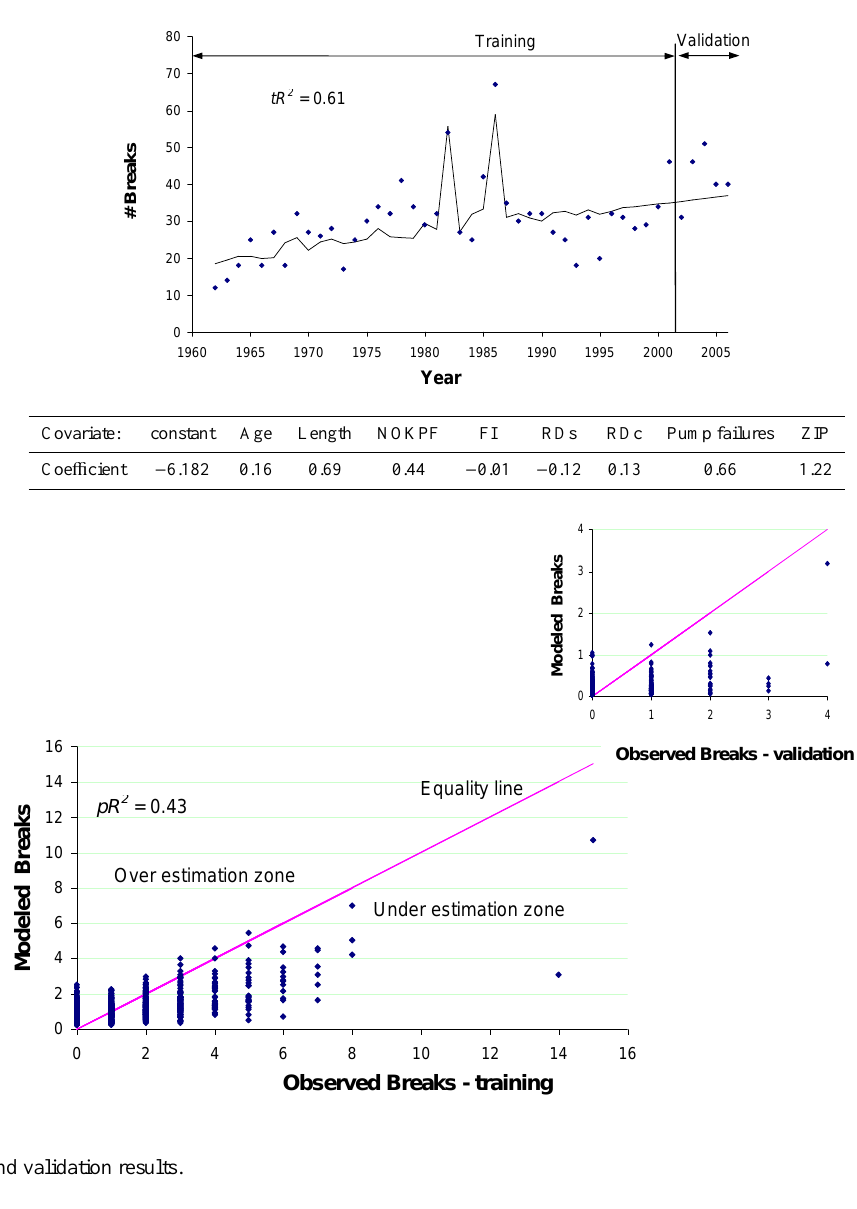
Table 1. Ranking ability of the model (validation